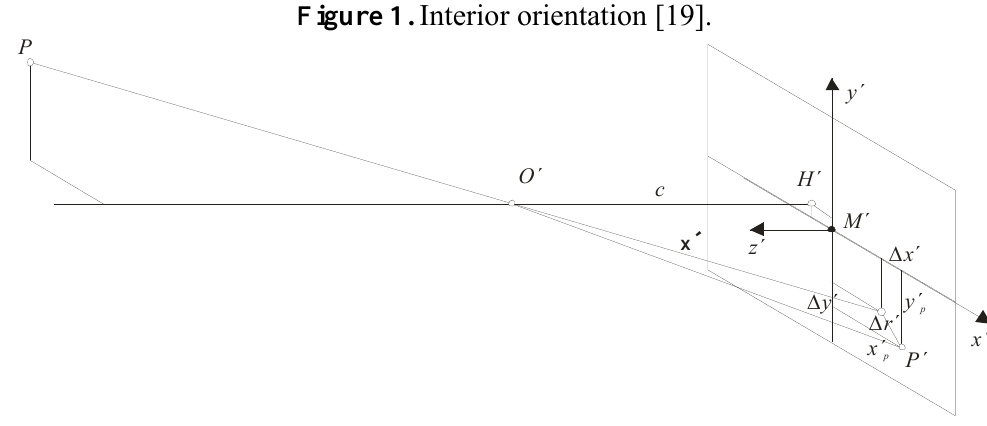
Figure 1. Interior orientation